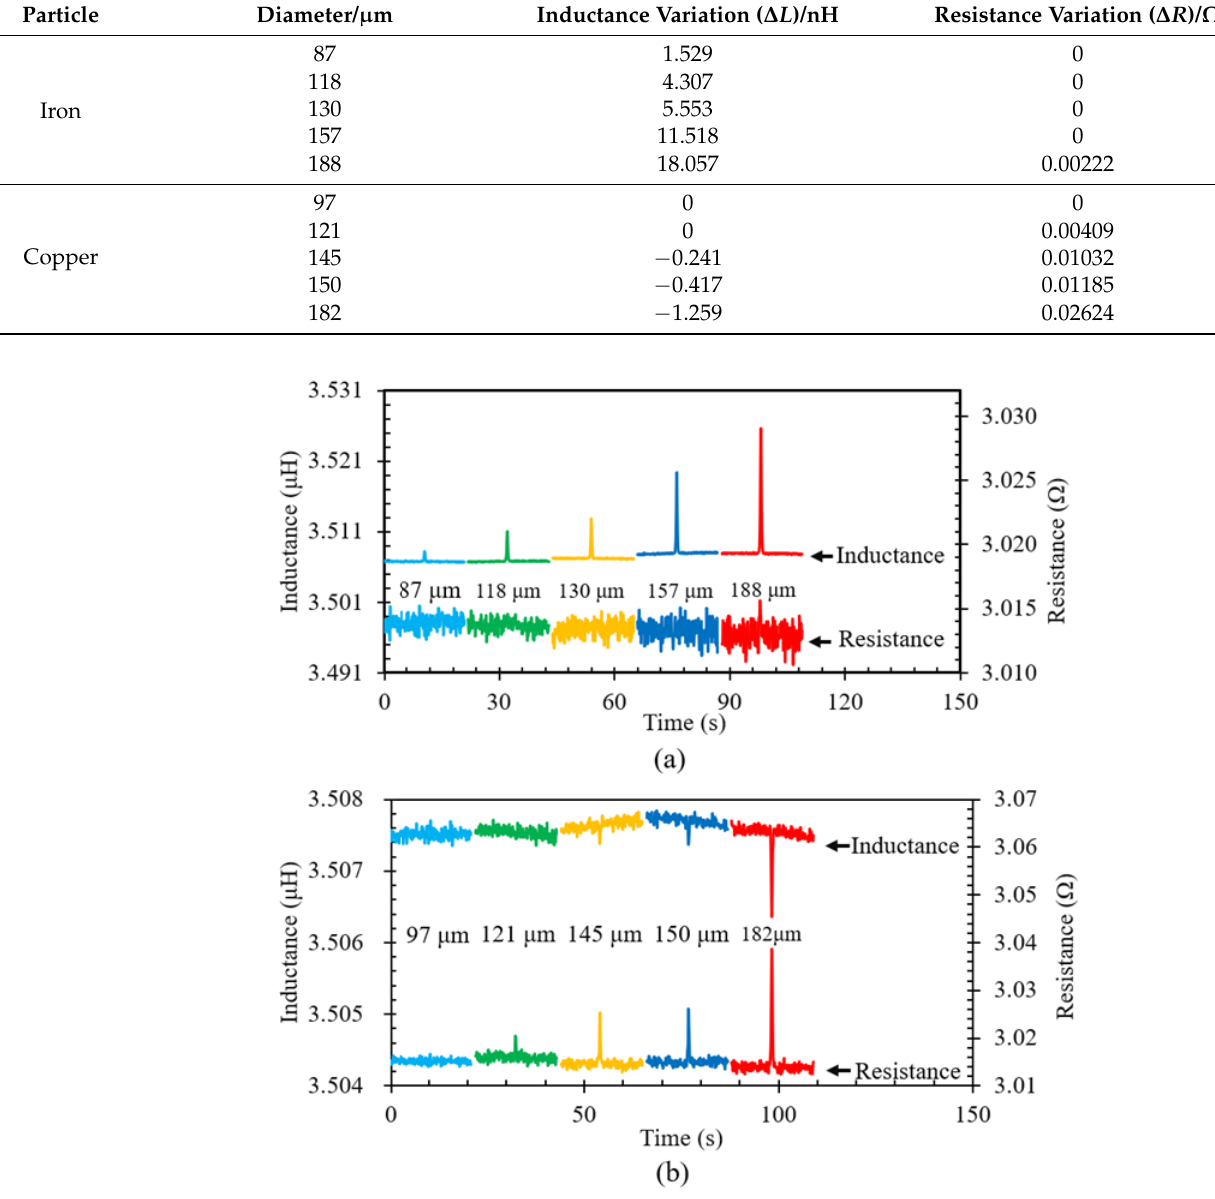
Figure 2. The inductance and resistance variations of the sensing coil induced by ( a ) iron and ( b ) copper particles measured by LCR meter. Table 1. The impedance variation induced by iron and copper